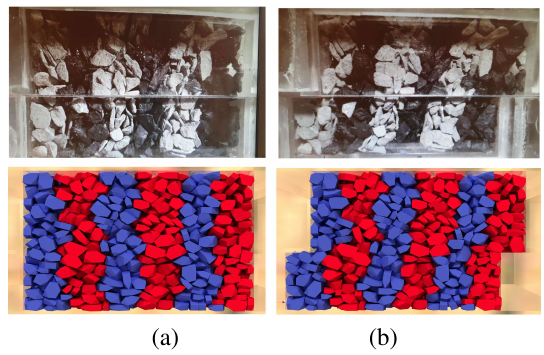
Figure 3. Front view of (a) initial and (b) final DEM states (Top: Qualitative illustration of typical shearing behavior experiment from [10])( P conf 100